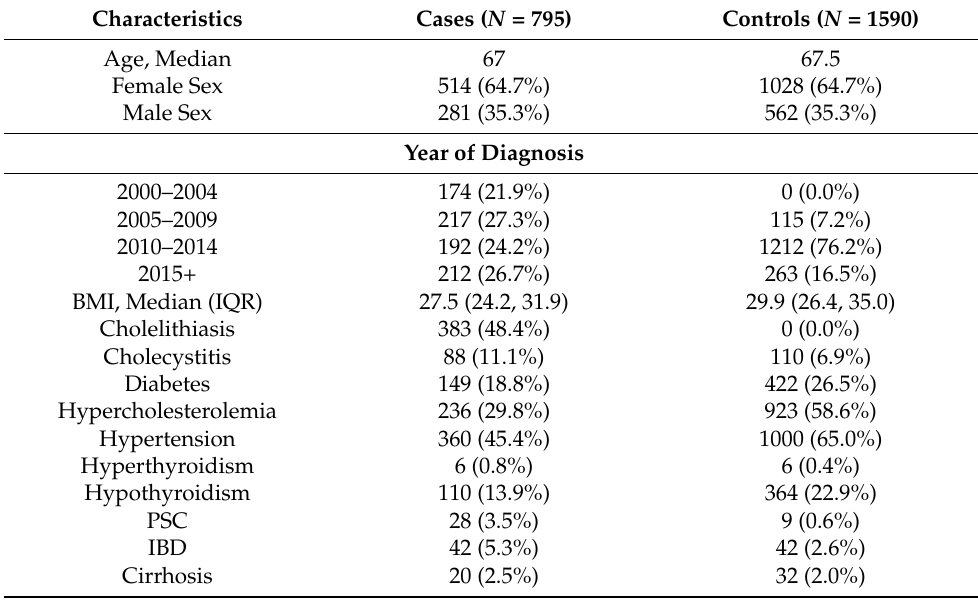
Table 1. Baseline characteristics of cases with gallbladder cancer and controls.